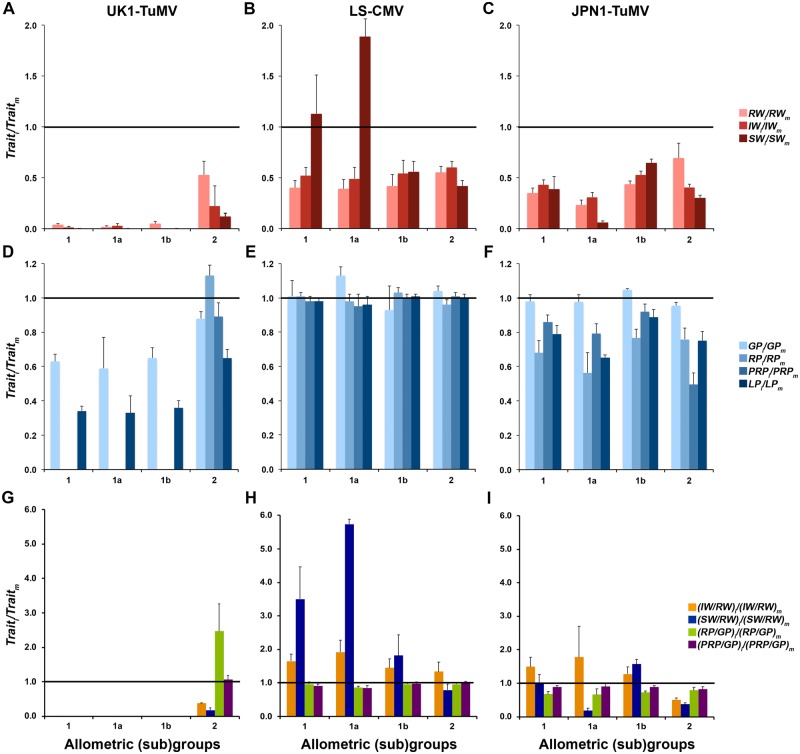
Effect of UK1-TuMV, LS-CMV and JPN1-TuMV infection on life-history traits for Arabidopsis allometric groups and subgroups. (A–C) Effect of viral infection on RW, IW and SW. (D–F) Effect of viral infection on GP, RP and PRP. (G–I) Effect of infection on the ratios IW/RW, SW/RW, RP/GP and PRP/GP. All effects were estimated as the ratio between infected (i) and mock-inoculated (m) plants. Data are presented for allometric Groups 1 and 2, and for Subgroups 1a and 1b, and are mean ± standard errors of plant genotype means. All values were different from zero except IW ratios for Group 1, and Subgroups 1a and 1b, in panel A.